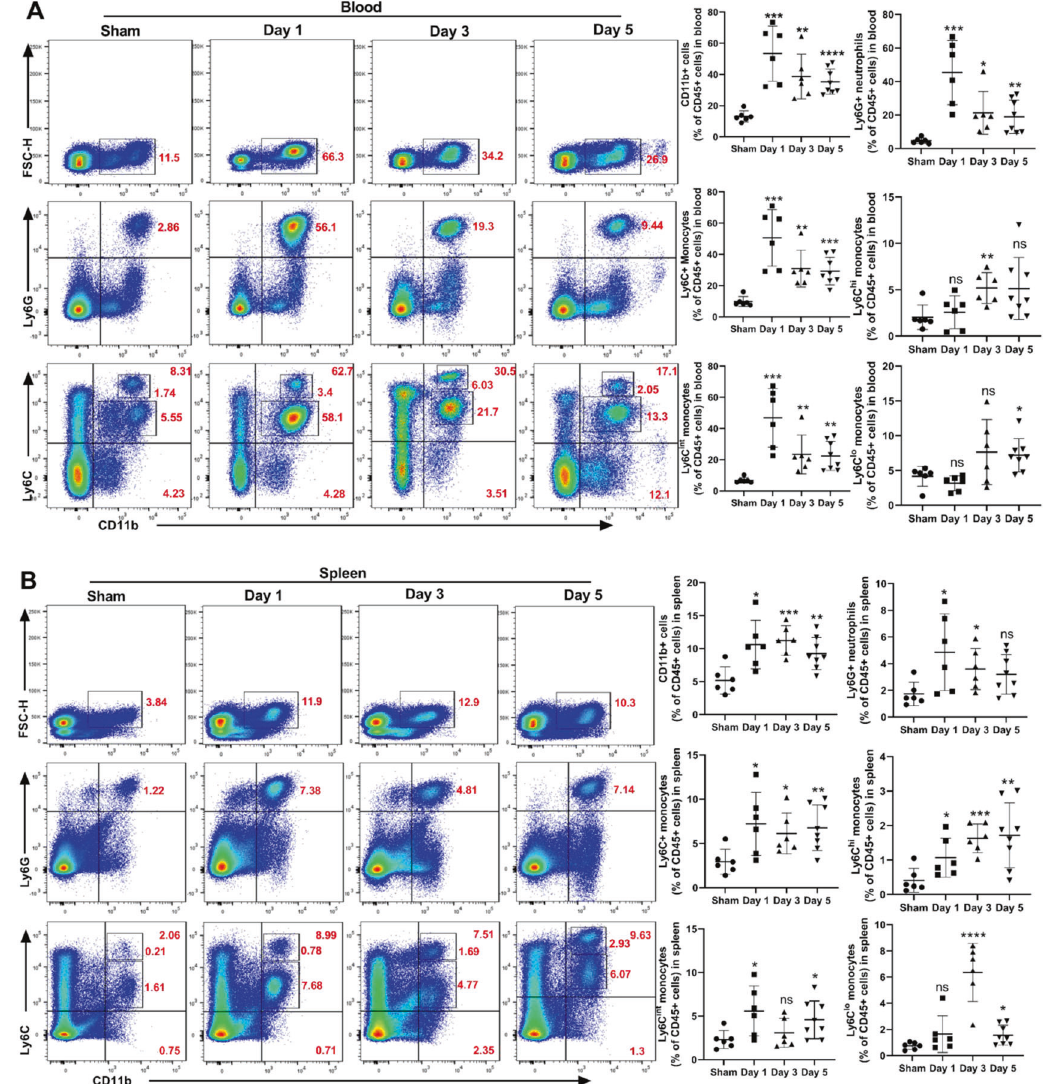
Fig. 4 GSDMD de fi ciency reduces the quantity of neutrophils in the blood, spleen, and bone marrow. A – C Flow cytometric analysis and quanti fi cation of CD11b + Ly6G + neutrophils and CD11b + Ly6C + monocytes in the blood ( n = 6 – 8) ( A ), spleen ( n = 6 – 8) ( B ) or bone marrow ( n = 6 – 10) ( C ) of WT mice at different time points (Day 1, Day 3, Day 5) after MCAO or sham surgery. D – F Flow cytometric analysis and quanti fi cation of CD11b + Ly6G + neutrophils and CD11b + Ly6C + monocytes in the blood ( n = 5 – 6), spleen ( n = 6) or bone marrow ( n = 6 – 10) of WT or GSDMD − / − mice 1 day or 5 days after MCAO. The data are presented as the mean ± SD. Statistical analysis: One-way analysis of variance followed by Bonferroni ’ s multiple comparison test ( A – C ) or multiple two-tailed unpaired Student ’ s t test ( D – F ). ns not signi fi cant, * P < 0.05, ** P < 0.01, *** P < 0.001, **** P < 0.0001 vs sham-operated mice. & P < 0.05, && P < 0.01, &&& P < 0.001, &&&& P < 0.0001 vs WT mice after